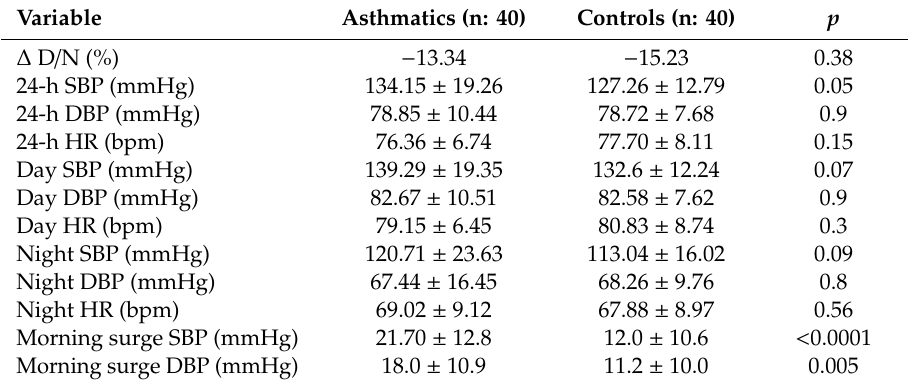
Table 2. Ambulatory blood pressure monitoring (ABPM) data—asthmatics vs. controls. Variable